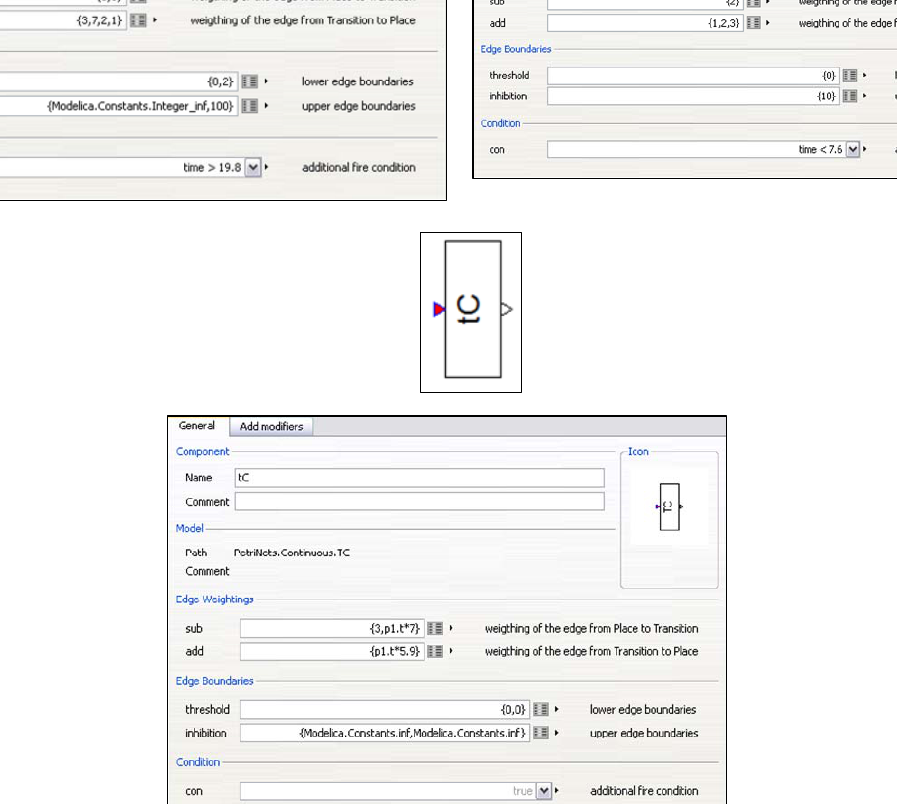
Figure 11: Property dialogs of discrete, stochastic and continuous